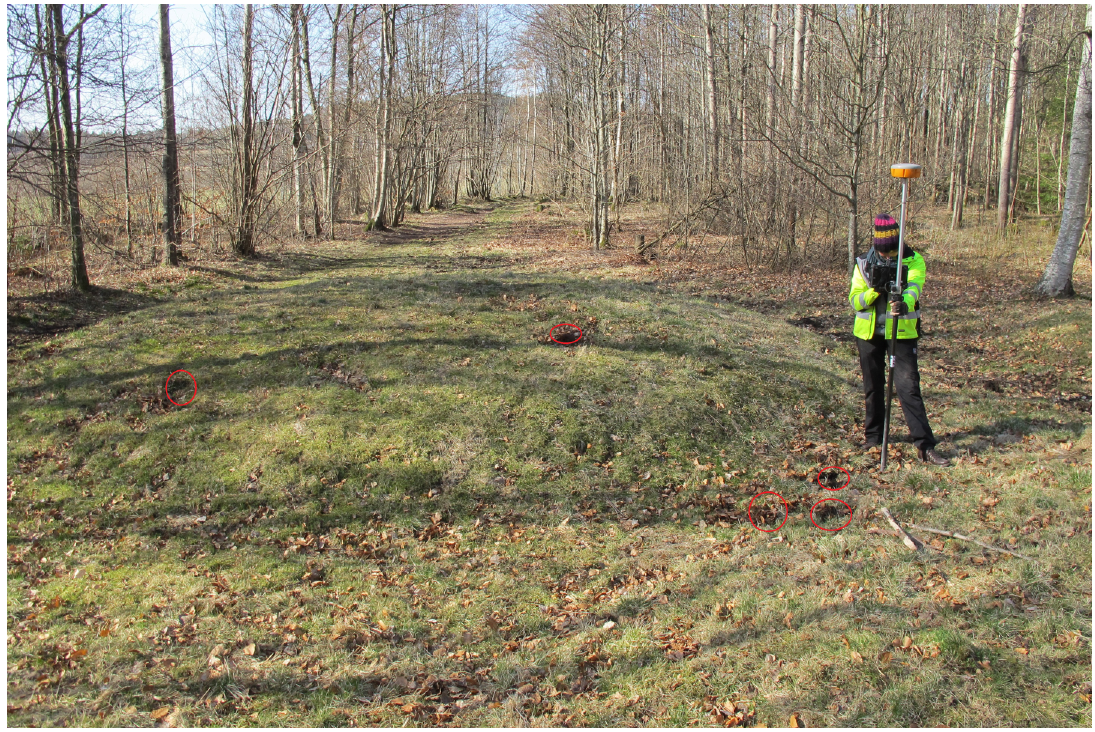
Figure 2. Documenting holes after illegal metal detecting on a Viking age grave mound in Vestfold. Red circles mark some of the holes. The illegal detecting had been reported by witnesses who several times had met metal detectorists at the protected site. Photo: Ragnar Orten Lie, Vestfold County